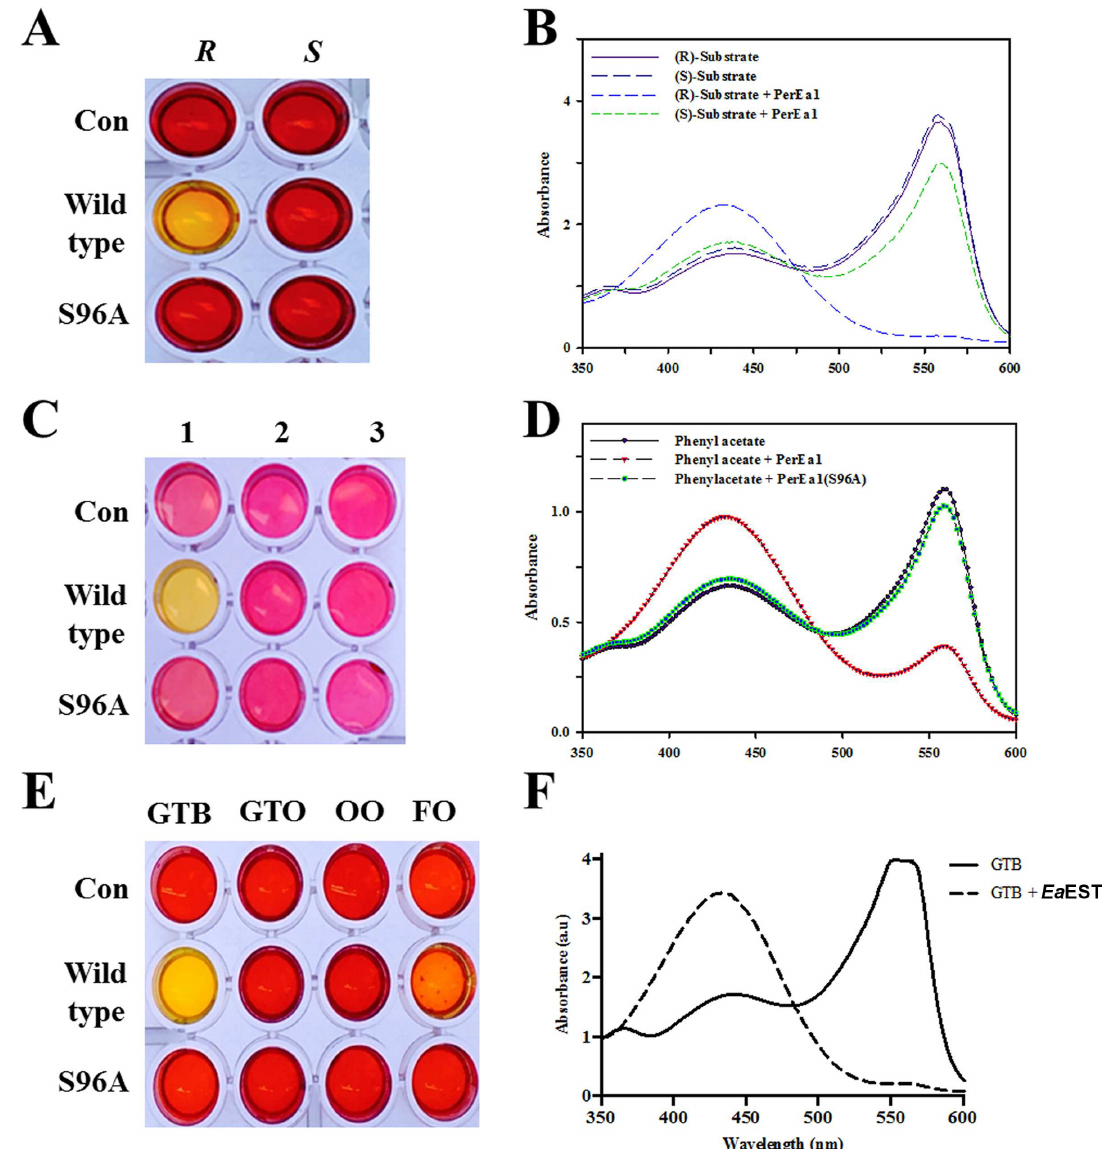
Fig 7. (A) pH shift assay for enantioselectivity analysisof Ea EST and S96A mutant conductedwith ( R )- and ( S )-methyl- 3-hydroxy-2-methylpropionate.(B) Absorbancespectra of the reactionmixtures in (A). (C) Hydrolysisof phenyl-substituted substrates: 1, phenyl acetate; 2, 2-phenylethyl acetate; 3, 2-methylbutyl acetate. (D) Absorbancespectra of 1 from (C) were measured. (E) Hydrolysis of glyceryl esters (glyceryltributyrate [GTB] and glyceryl trioleate [GTO]) and oils (olive oil [OO] and fish oil [FO]) by Ea EST was investigated. (F) Absorbance spectra of GTB hydrolysisby wild-type Ea EST were